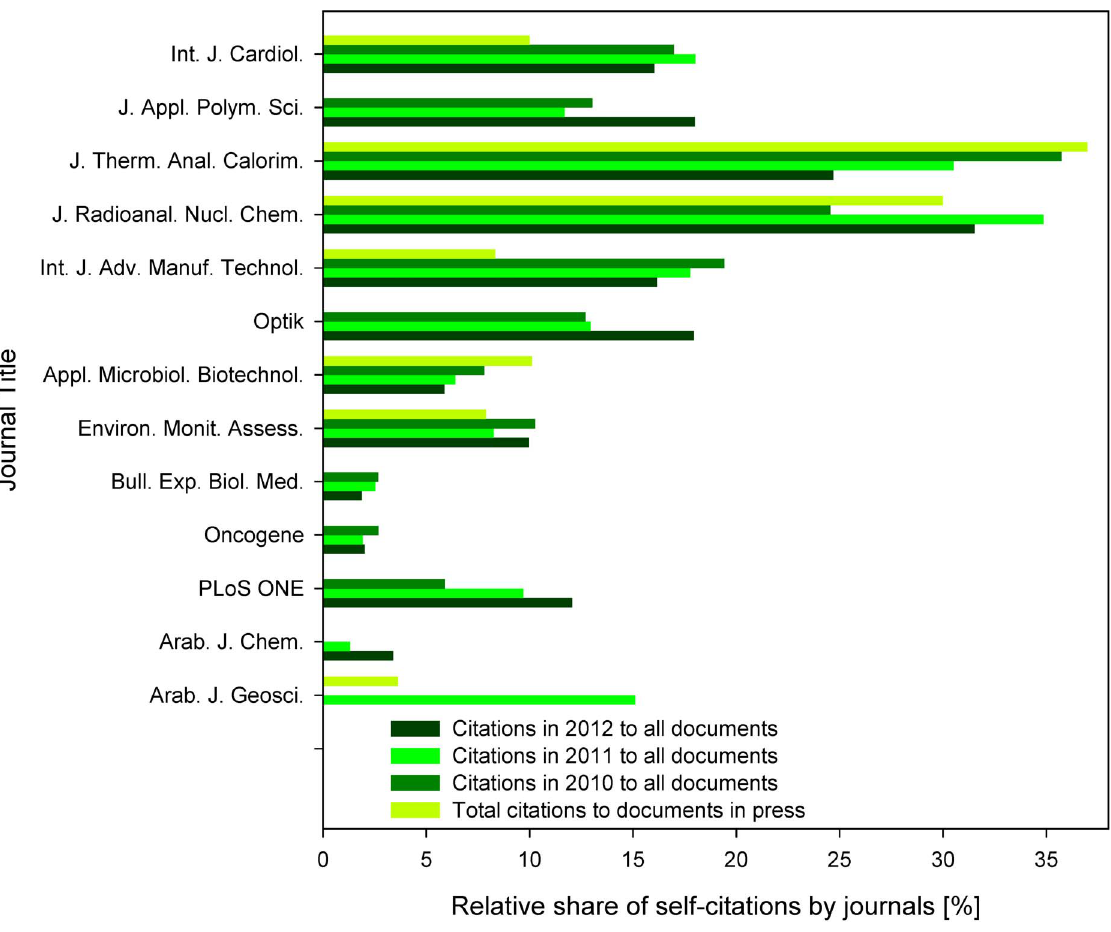
Figure 6. Relative share of journals’ self-citations. The data represent shares of citations, which originate from the same source journal title as the cited document. Indicated is the ratio of journals’ self-citations among the total citations to documents in press and among citations in 2010, 2011 or 2012 to all documents published in the respective journal. Zero values indicate absence of the source data in Scopus.